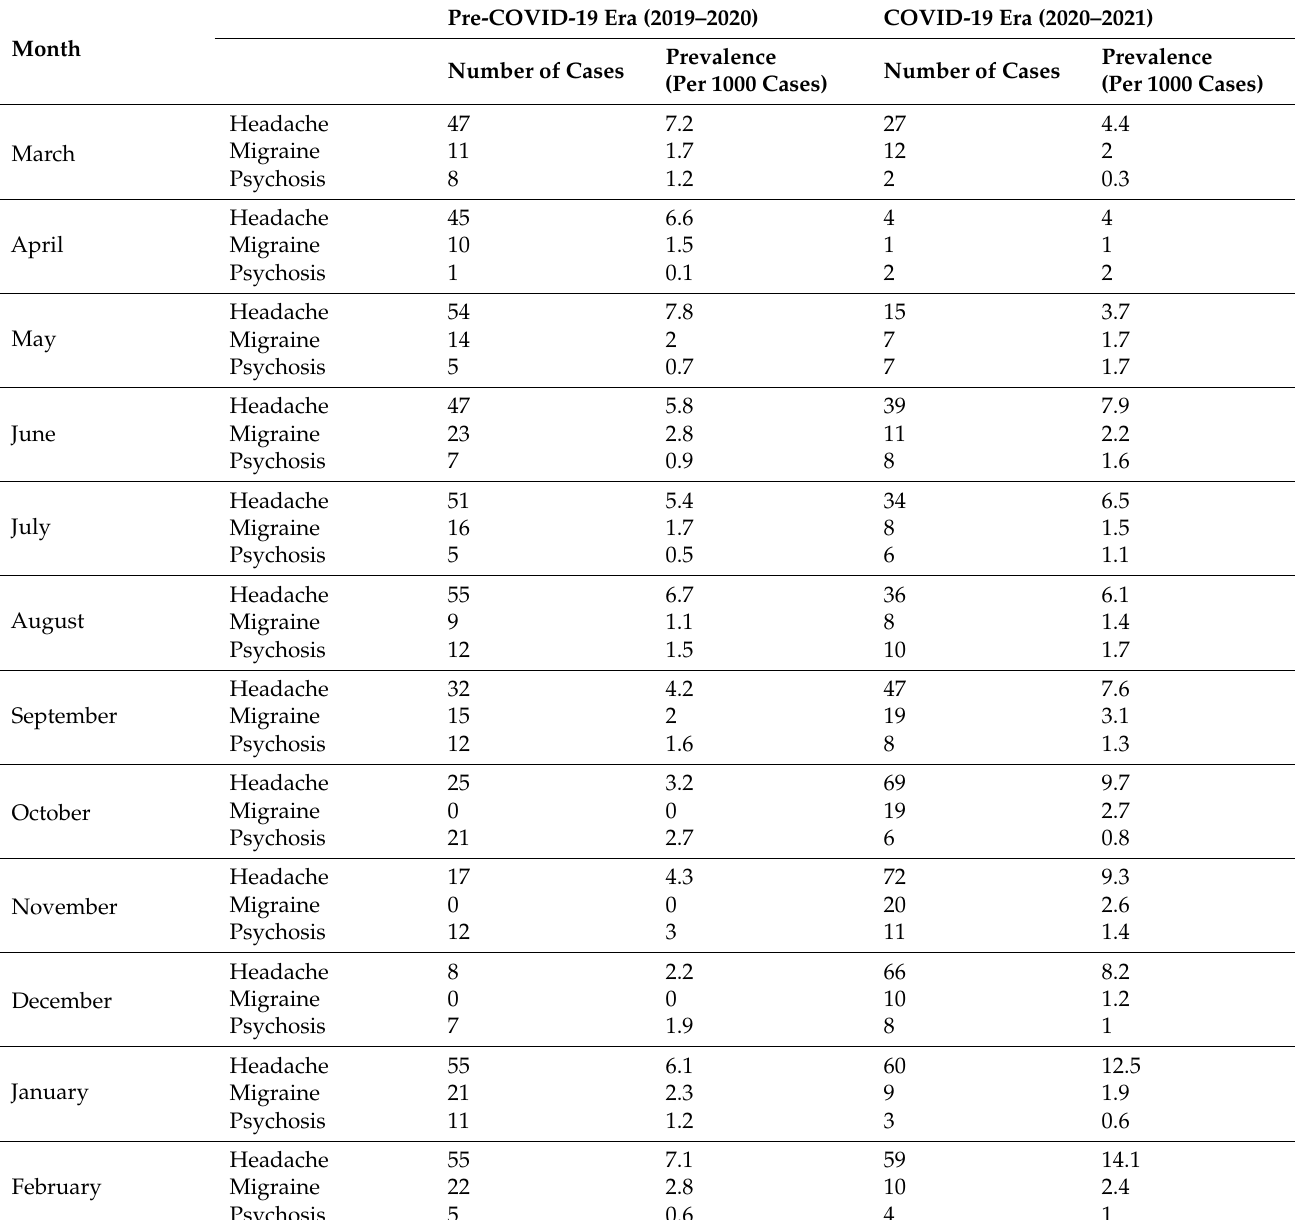
Table 3. Cases of headache, migraine, and psychosis in the pre-COVID-19 and COVID-19